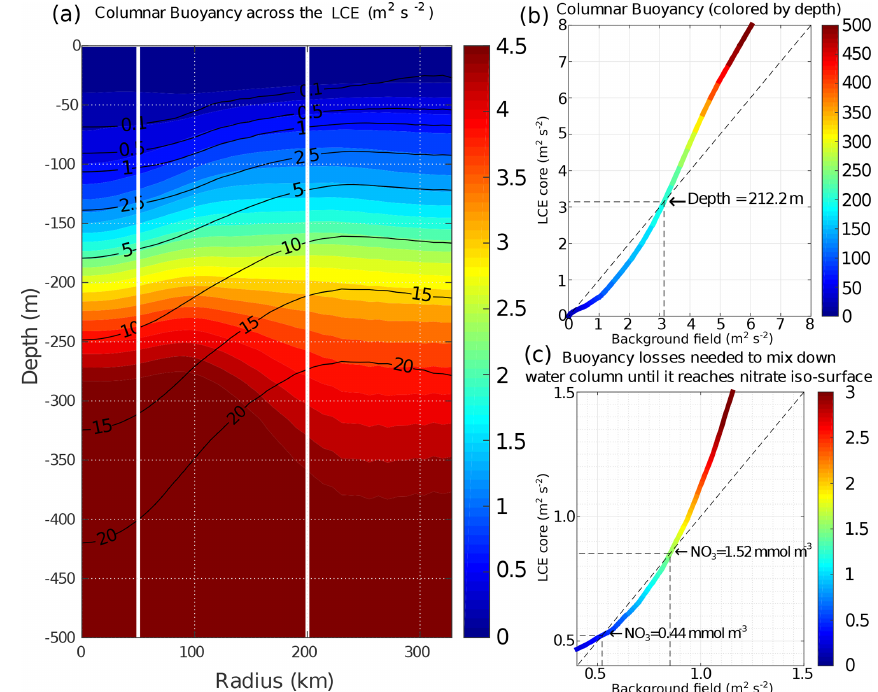
Figure 10. (a) Columnar buoyancy transect composite in summer, corresponding to pre-winter mixing season. Iso-nitrate concentrations (black contours) are superimposed. Vertical white lines delimit the three dynamical fields of the LCE composite. (b) Vertical increase in the columnar buoyancy in the LCE core versus the background GoM. Colors refer to depth. (c) Columnar buoyancy loss required to mix the water column down to the iso-nitrate surface defined by the line